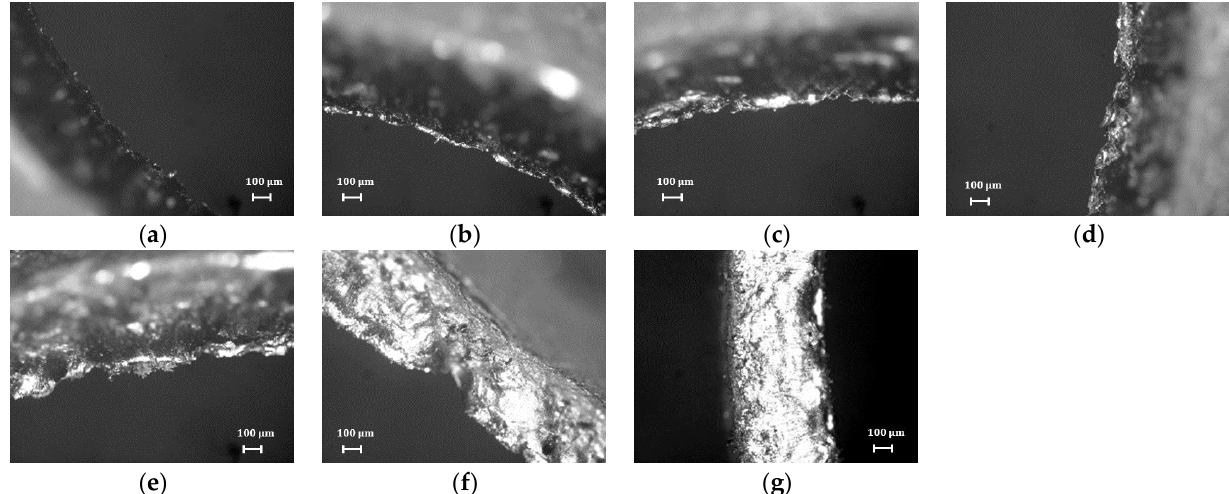
Figure 10. Edge cracks according to stroke; ( a ) stroke 5 mm; ( b ) stroke 6 mm; ( c ) stroke 7 mm; ( d ) stroke 8 mm; ( e ) stroke 9 mm; ( f ) stroke 10 mm; ( g ) stroke 11 mm.